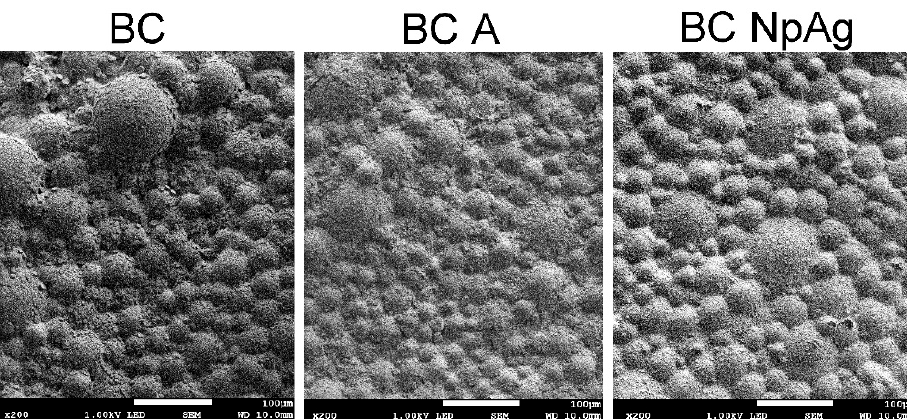
Figure 2. Comparison of bacterial adhesion to the surface of the tested materials after 14 days of incubation in bacterial suspension: Modified bone cements—1.5% w / w of modifiers additive (SEM 200 ×